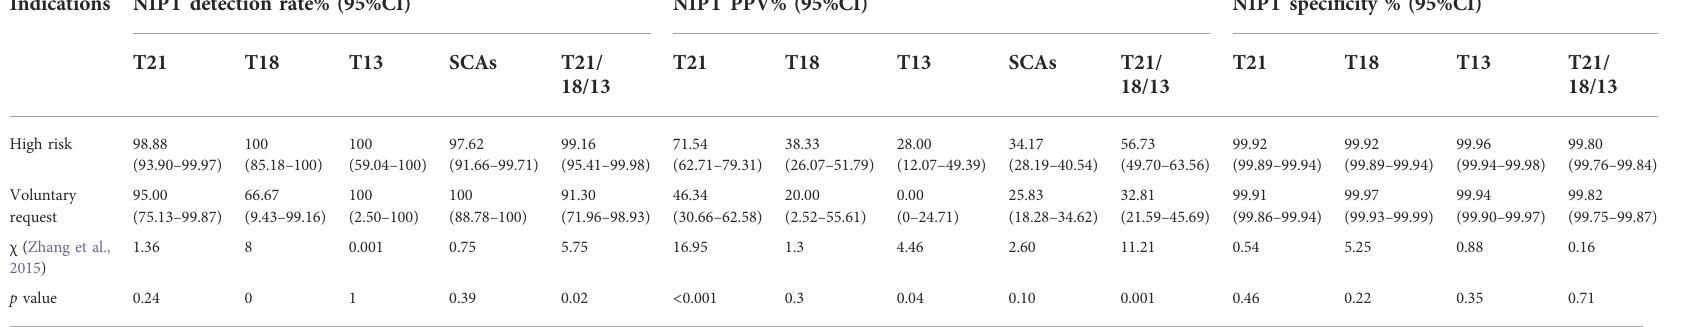
TABLE 7 Comparison of the screening ef fi ciency of NIPT between low-risk and high-risk pregnancy women. Indications NIPT detection rate%